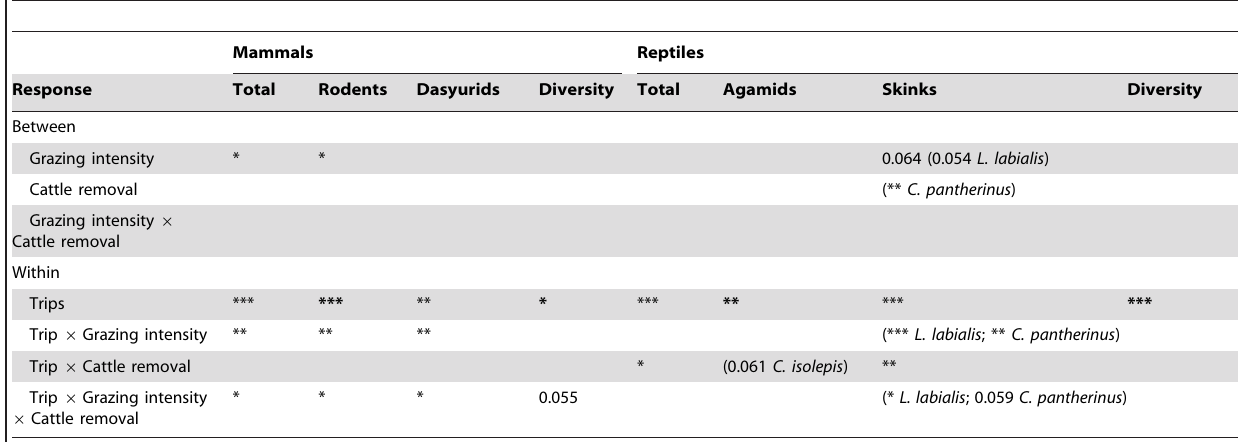
Table 2. Summary of repeated measures ANOVA results on the effects of grazing history and cattle removal on the abundance of small vertebrates.